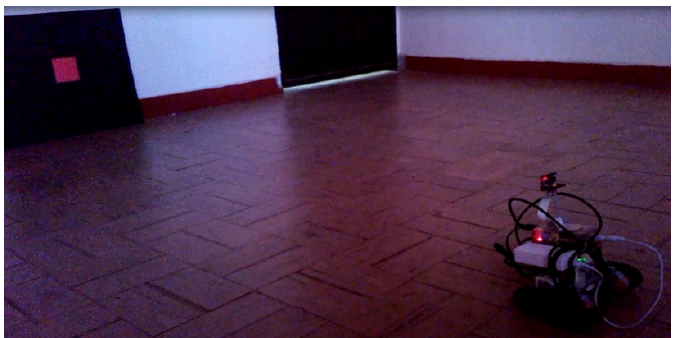
Figure 12. Robot in operation. Red square is the objective to be sensed by the camera.